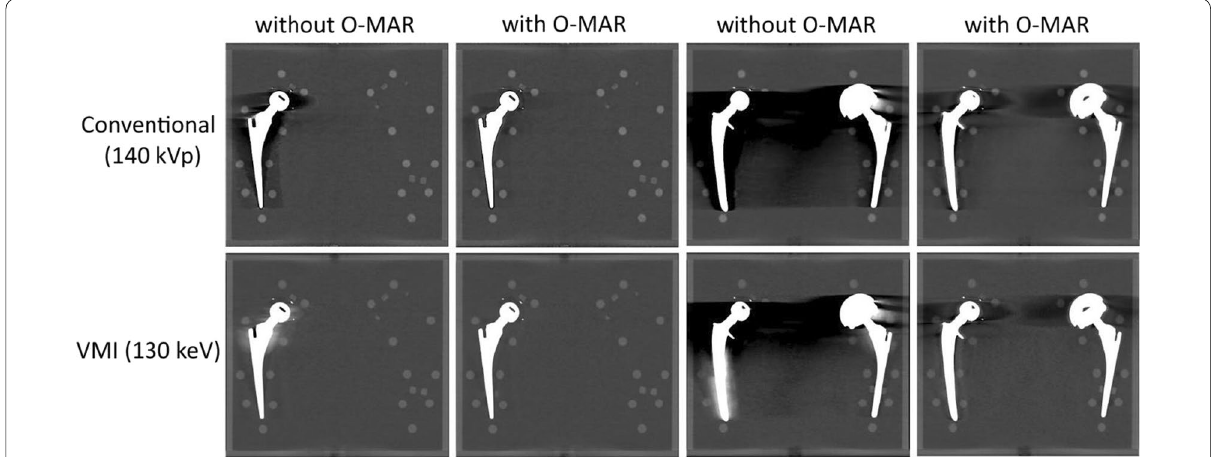
Fig. 6 Coronal images of the phantom with unilateral or bilateral prostheses. Conventional images (upper row) and virtual monochromatic images (bottom row) were reconstructed with and without O-MAR. Unilateral images: phantom with prosthesis at the right (cup: UHMWPE, head: ZTA, stem: TiAlV). Bilateral images: phantom with prostheses at the right (cup: UHMWPE, head: ZTA, stem: CoCrMo) and left (cup: CoCrMo, head: CoCrMo, stem: TiAlV). UHMWPE ultrahigh molecular weight erthylene, ZTA Zirconia toughened aluminum, TiAlV titanium–aluminum–vanadium, CoCrMo